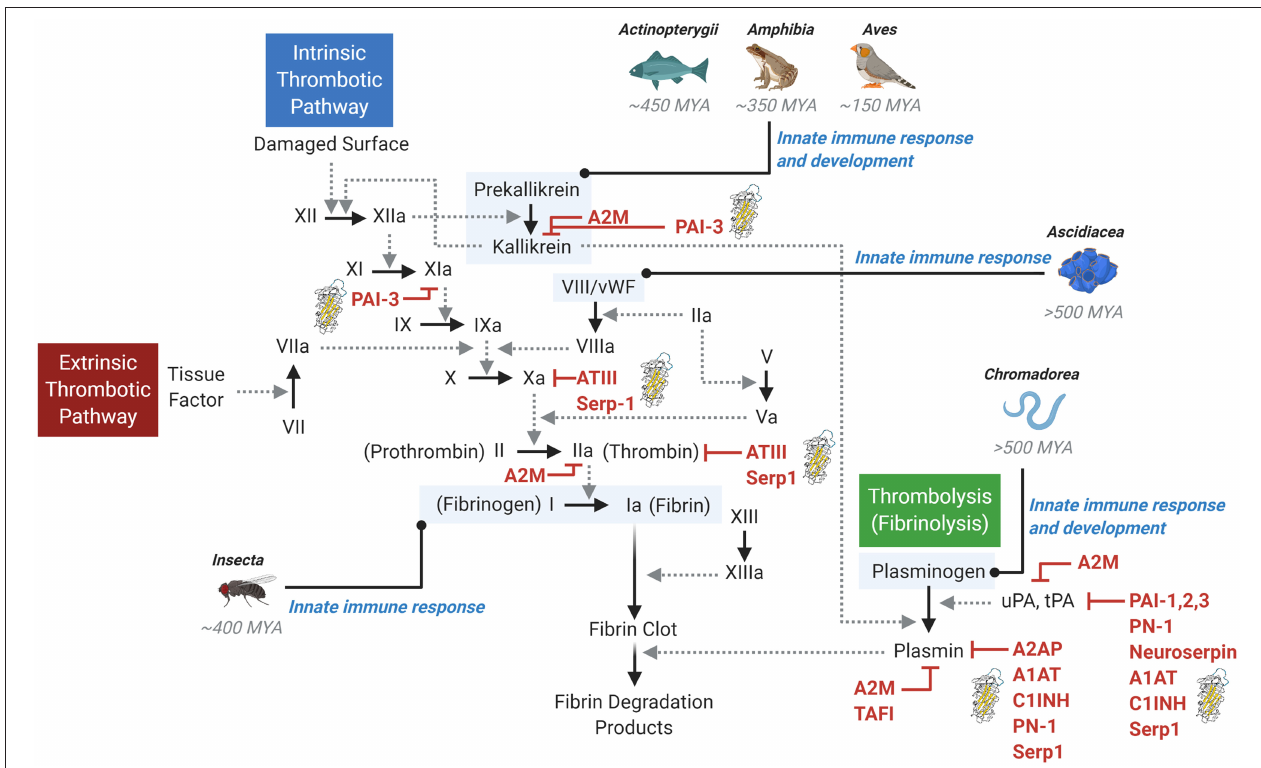
FIGURE 1 | The thrombotic and thrombolytic cascades and primordial immune response. The thrombotic pathways (intrinsic and extrinsic) and the thrombolytic (fibrinolysis) pathway involve a complex cascade of protease activation. Solid arrows indicate the conversion to an active protease, while dotted line arrows indicate the activity of the activating upstream protease. A variety of inhibitors are shown, with serpin inhibitors denoted by a serpin protein structural image. Examples of early primordial immune response origins are noted in context of the pathways. MYA, million years